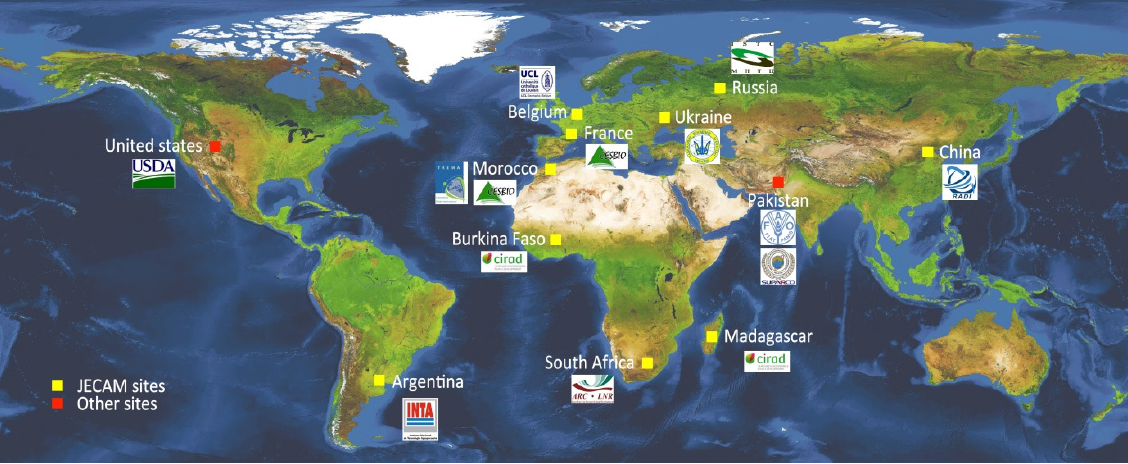
Figure 3. Twelve globally distributed sites selected for algorithm and system design.